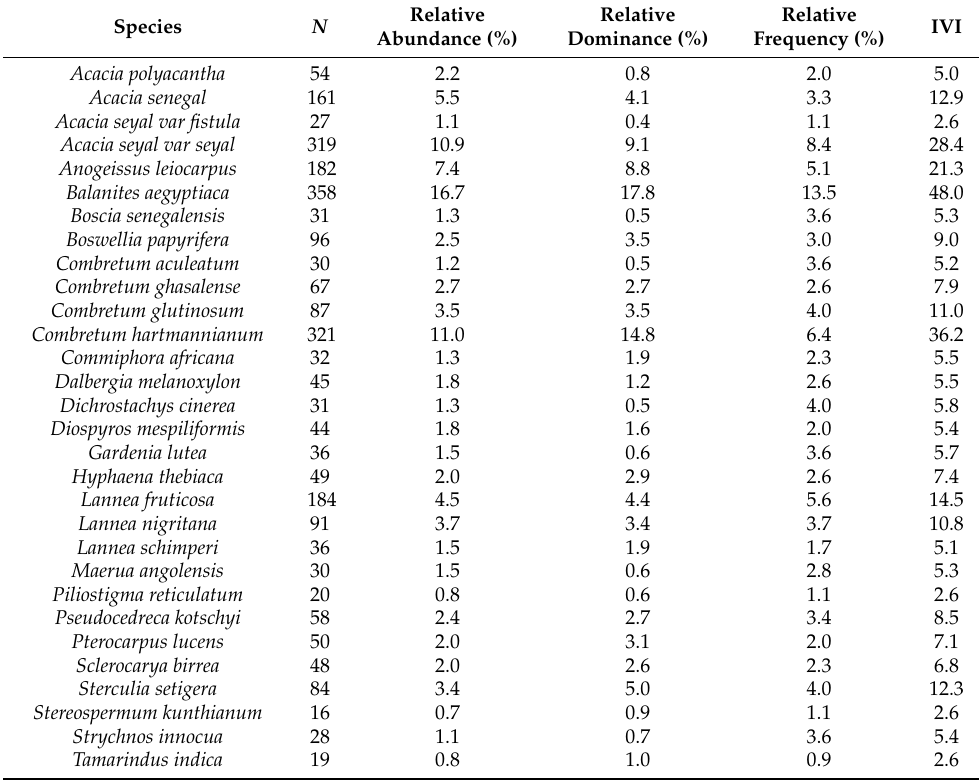
Table A2. Total number, relative abundance, dominance, frequency and IVI of the tree species counted and measured in the non-disturbed site in the Dinder Biosphere